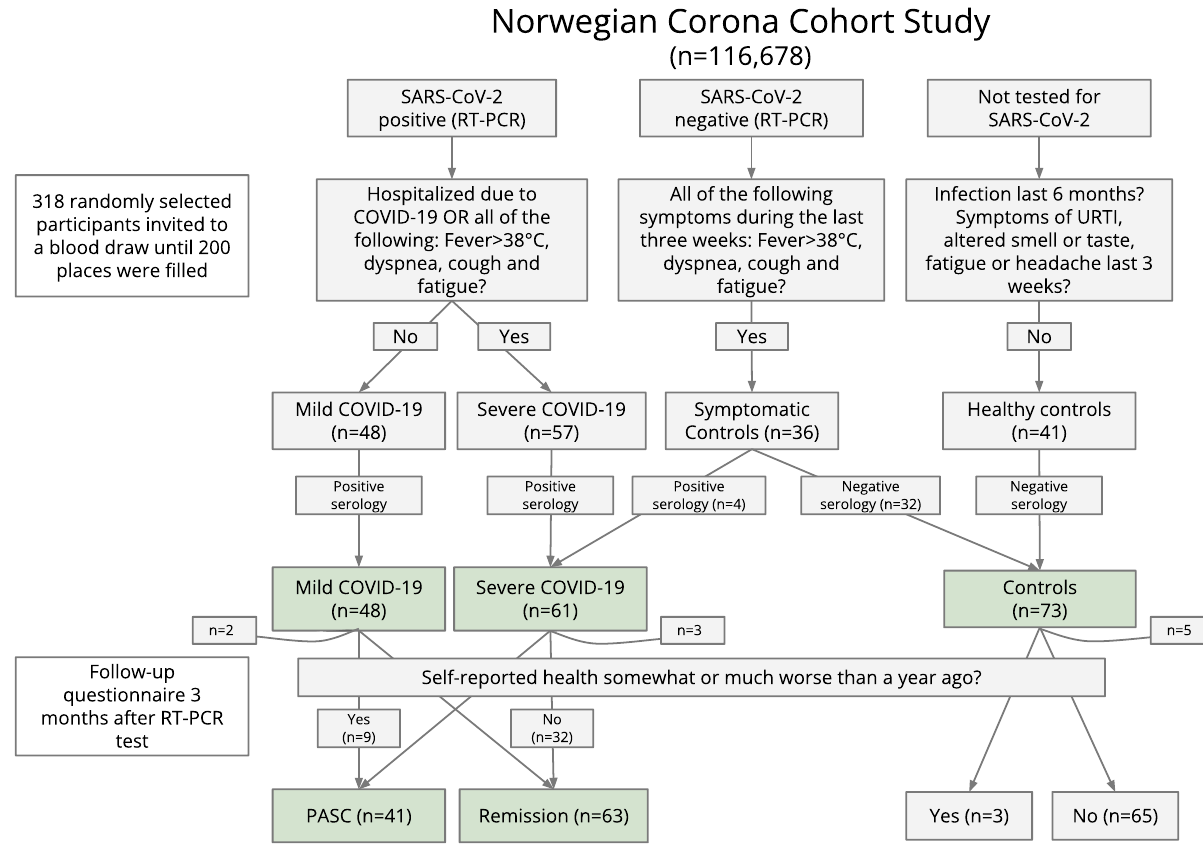
Figure 1. Overview of the sampling scheme. 184 of the 200 participants who agreed to a blood draw showed up for their appointment and completed the baseline questionnaire. Two participants lacked data and were excluded from the study, bringing the final number of participants to 182. Four participants with a negative SARS-CoV-2 RT-PCR test and who reported symptoms of severe COVID-19 had a positive serology test. They were considered false negatives and reclassified as severe COVID-19. Ten participants were treated as ‘lost to follow-up’, as they did not return the three-month follow-up questionnaire despite reminders. The control group was not included in the long-COVID EWAS